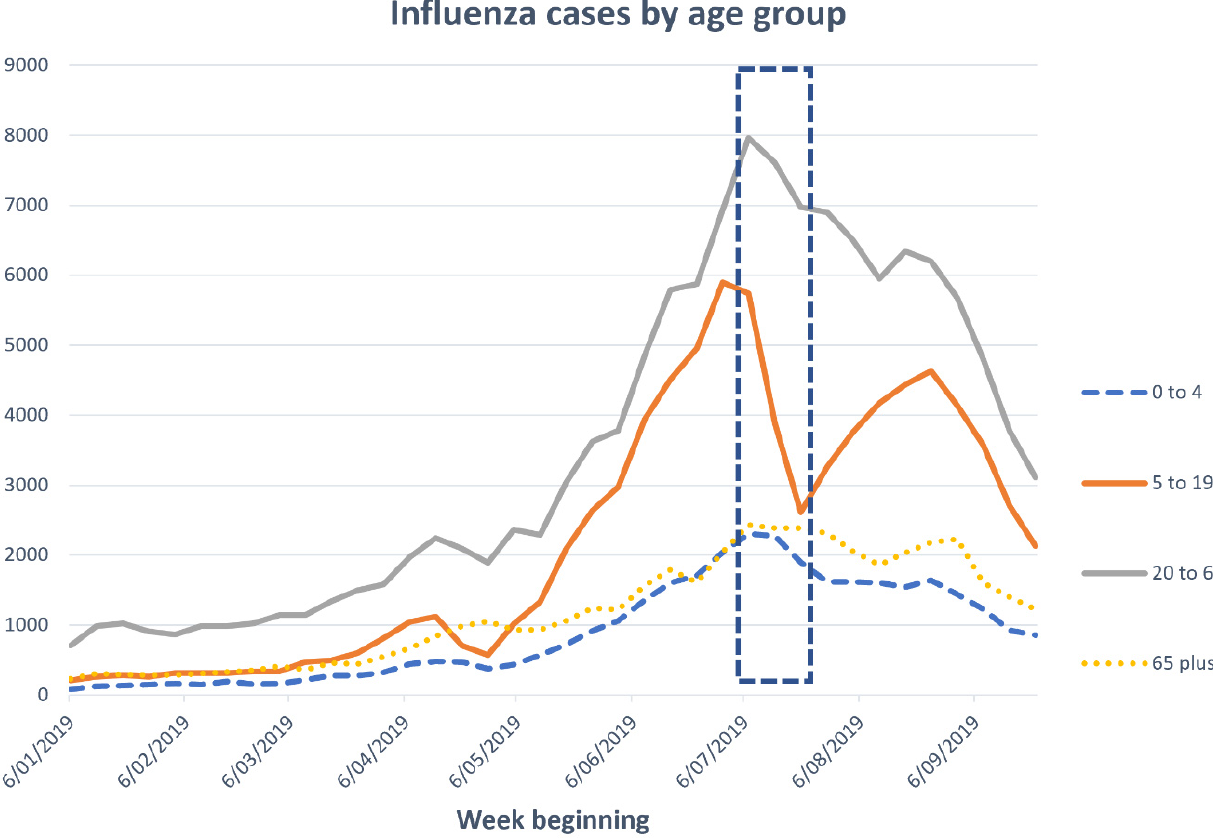
Figure 2. Influenza cases by age group (box shows the school holidays